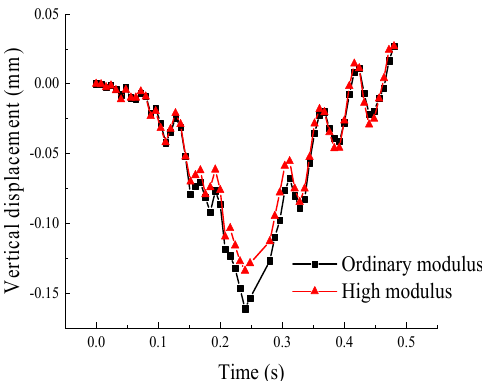
Figure 4. Comparison of vertical displacement in the upper surface layer.